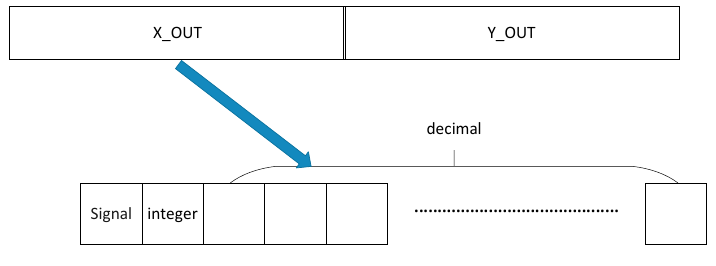
Figure 6. Output format of Cordic IP core.